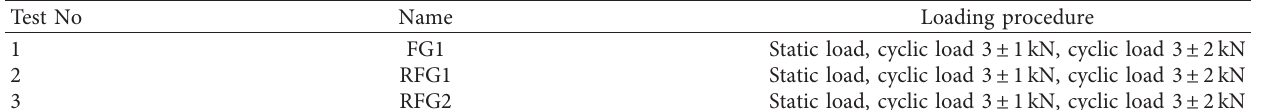
Table 2: Configuration of the model